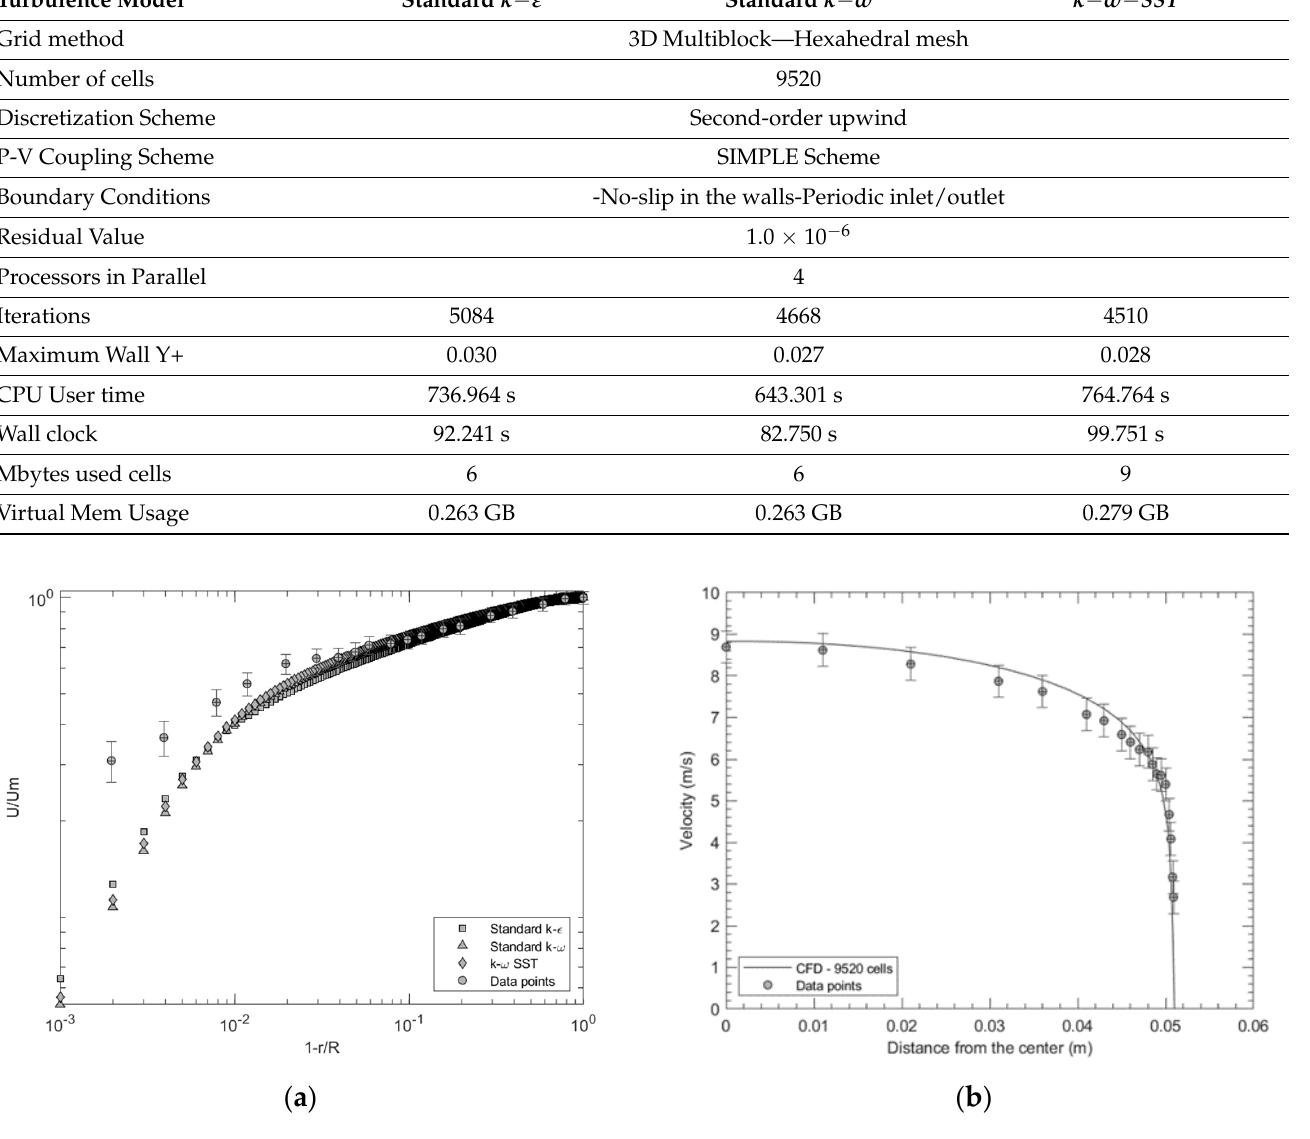
Figure 7. ( a ) Comparison of the normalized velocity profile for different turbulence models; ( b ) Velocity profile.